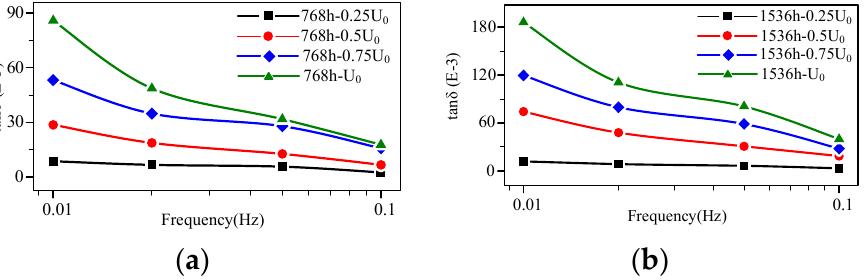
Figure 11. High-voltage FDS of cable at the late aging stage: ( a ) aging time 768 h; ( b ) aging time 1536 h. According to [15,16], the high-voltage FDS of water-tree-aged cable also increases as the detection voltage rises. In addition, the high-voltage FDS of the water-tree-aged cable also exhibits the hysteretic effect, i.e., when a higher voltage is applied between the sweeps at the same low voltage level, the loss levels from a second measurement sweep (at the same voltage level) are higher than those in the previous sweep. The previous and the second FDS curves of low voltage level (0.25 U 0 ) before and after a higher voltage ( U 0 ) at the late aging stage (thermally aged 1536 h) are shown in Figure 12. According to Figure 12, the lower voltage detection curves are crossed in frequency domain. This means that, even at the late stage, thermal aging does not cause the hysteresis effect. Therefore, the water treeing and thermal aging can be distinguished by hysteresis phenomenon.